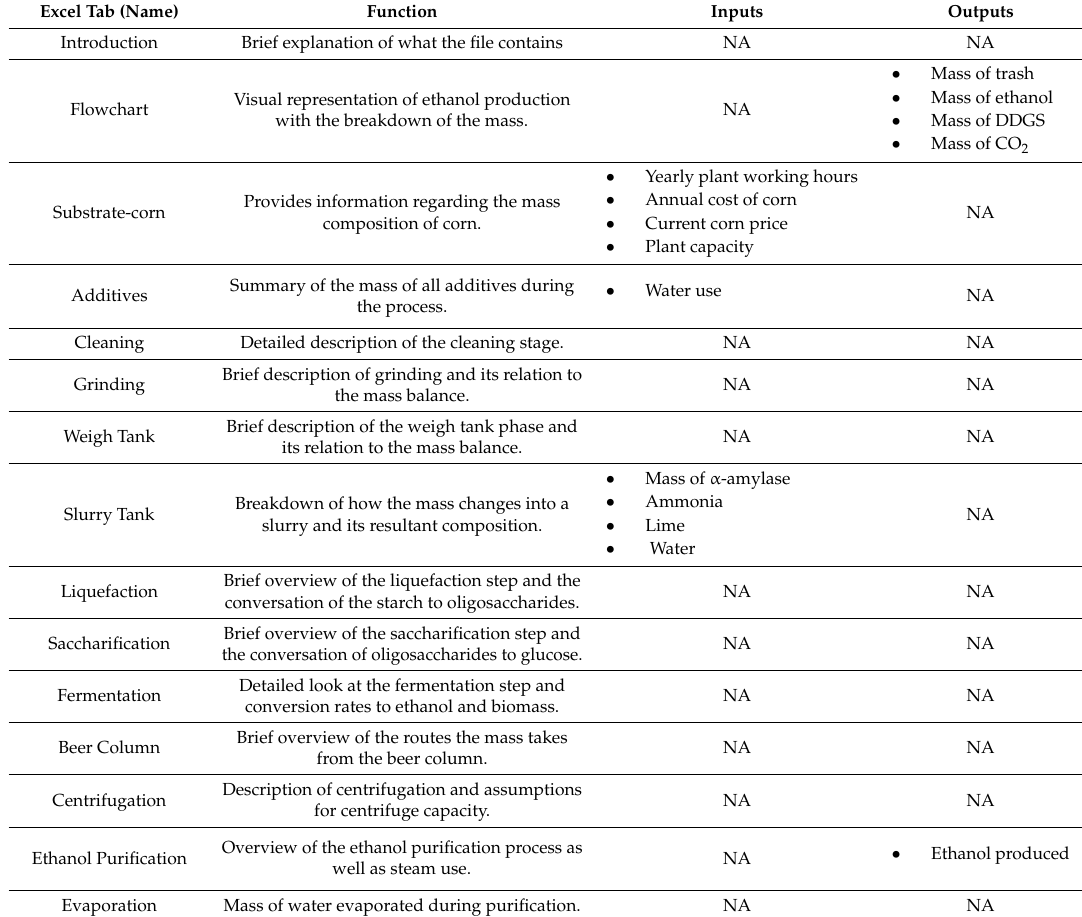
Table 1. Legend to the Technoeconomic Model (Excel spreadsheet in Supplementary Materials): Bioethanol Plant Production